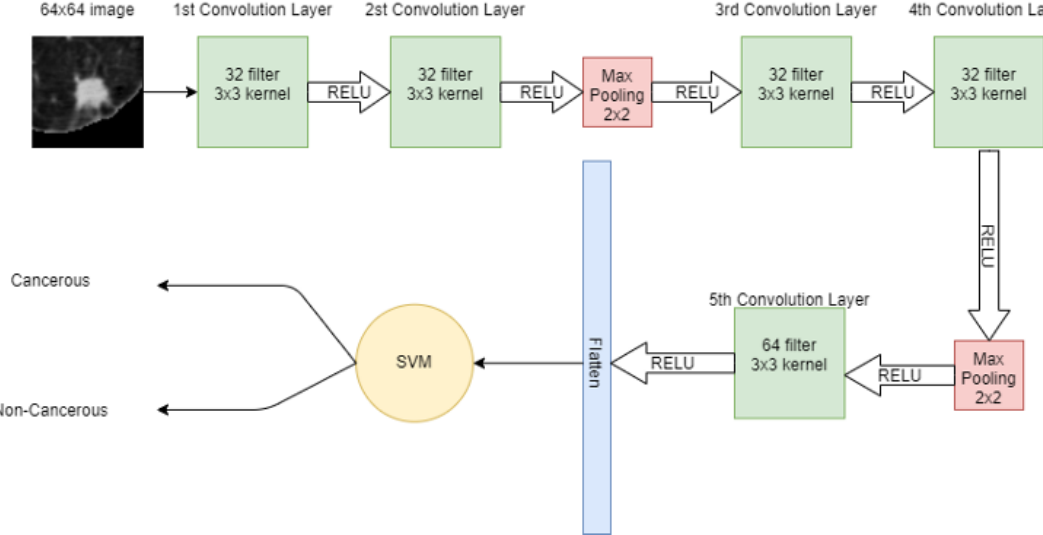
Figure 4. Architecture of proposed hybrid model (CNN +